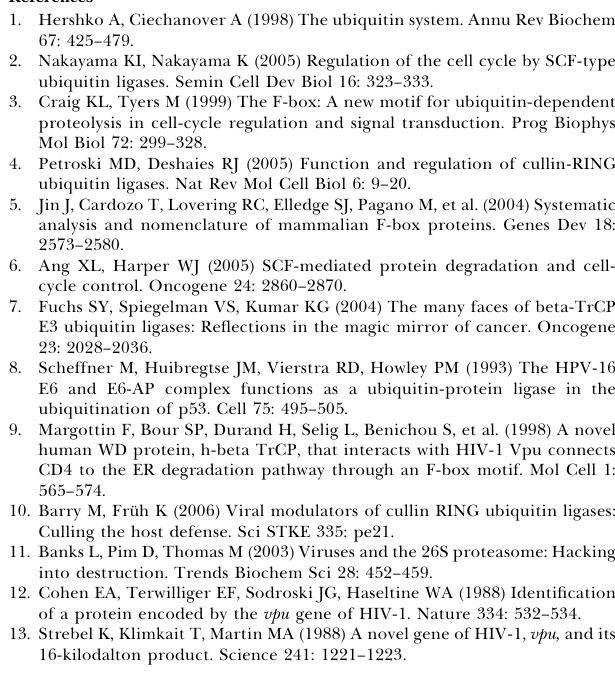
Figure S3. Vpu Is Phosphorylated Outside the DSGXXS